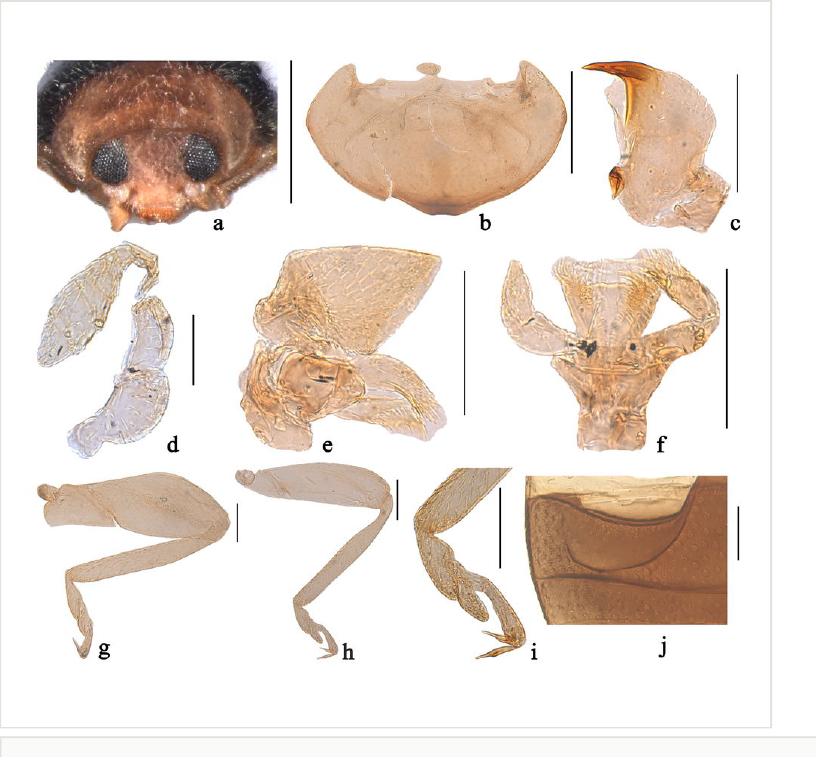
Figure 1. Main characters of the genus Nephaspis Casey: (a) head; (b) prothorax, ventral; (c) mandible; (d) antenna; (e) maxilla; (f) labium; (g) hind leg; (h) front leg; (i) tarsi; (j) part of abdominal ventrite 1 and 2. Scale bars: a =0.5 mm, b =0.2 mm, c–j =0.1